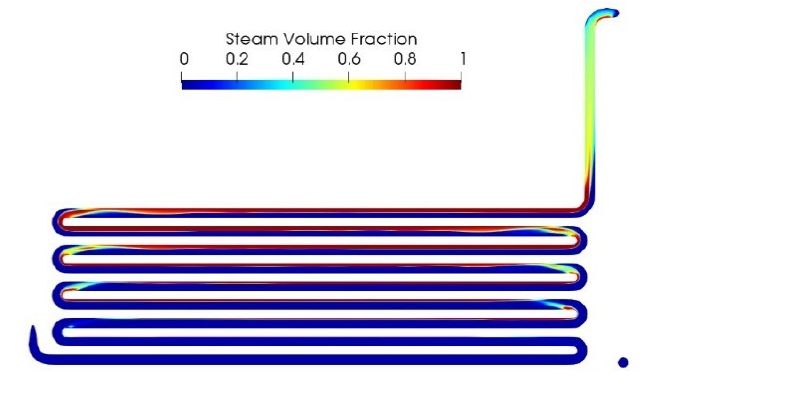
Figure 24. Vapor phase fraction contour within First Tubes in the convection box on a vertical cut.